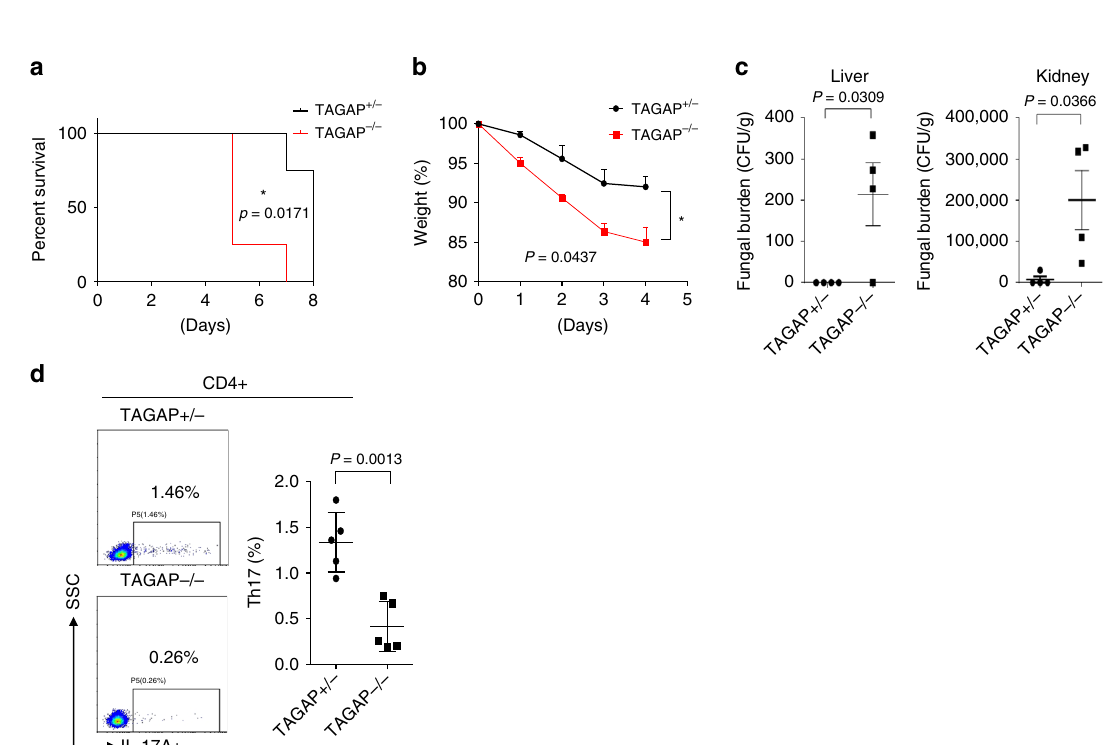
Fig. 5 TAGAP is important for T helper cell polarization in mice. a Cells of lymph nodes and spleens from heterozygous control or TAGAP-de fi cient mice were analyzed by fl ow cytometry by gating on CD4 + , and analyzed by IL-17A or IFN- γ -producing cells. Right panel indicates quantitative result, and the top right panel represents data from spleen, and the bottom right data represent data from lymph nodes ( n = 8). b Heterozygous control or TAGAP-de fi cient mice were immunized subcutaneously with 200 μ g MOG 35 – 55 and 400 μ g Mycobacteria tuberculosis H37RA in 200 μ L of complete Freund ’ s adjuvant (Difco). Lymph nodes were collected 10 days later and single-cell suspensions were prepared. Cells were cultured with MOG 35 – 55 (20 μ g/mL) for another 3 days, followed by fl ow cytometry analysis of indicated cell populations. Right panel were quantitative results ( n = 4). c Heterozygous control or TAGAP- de fi cient mice were immunized as in b , except for immunization with 200 μ g MOG 35 – 55 plus CFA and 400 μ g heat-killed C. albicans (sc-5314). Right panel were quantitative results ( n = 4). d Heterozygous control or TAGAP-de fi cient mice were immunized as in b , except for immunization with 200 μ g MOG 35 – 55 plus CFA only ( n = 4). ns: P = 0.5226 and P = 0.288. e Naive CD4 + T cells were isolated from spleens of heterozygous control or TAGAP- de fi cient mice, and polarized in vitro for 3 days in the Th17 or Th1 cell polarization conditions. Cells were analyzed by fl ow cytometry by gating on CD4 + , and analyzed by IL-17A or IFN- γ -producing cells. Right panel were quantitative results ( n = 10). ns: P = 0.1848 and P = 0.9952. f Wild-type mice were injected intravenously with 2 × 10 5 live C. albicans (sc-5314) in 100 μ L PBS. Ten days later, CD4 + T cells were isolated from spleen, and co-cultured with DCs isolated from heterozygous control or TAGAP-de fi cient mice for another 3 days together with indicated numbers of heat-killed C. albicans . Cells were analyzed by fl ow cytometry by gating on CD4 + , and analyzed by IL-17A or IFN- γ -producing cells ( n = 6). Right panel were quali fi ed results. * P < 0.05; ** P < 0.01; *** P < 0.001 based on two-sided unpaired t test a – f . All error bars represent SEM of technical replicates. Data are representative of two independent experiments.